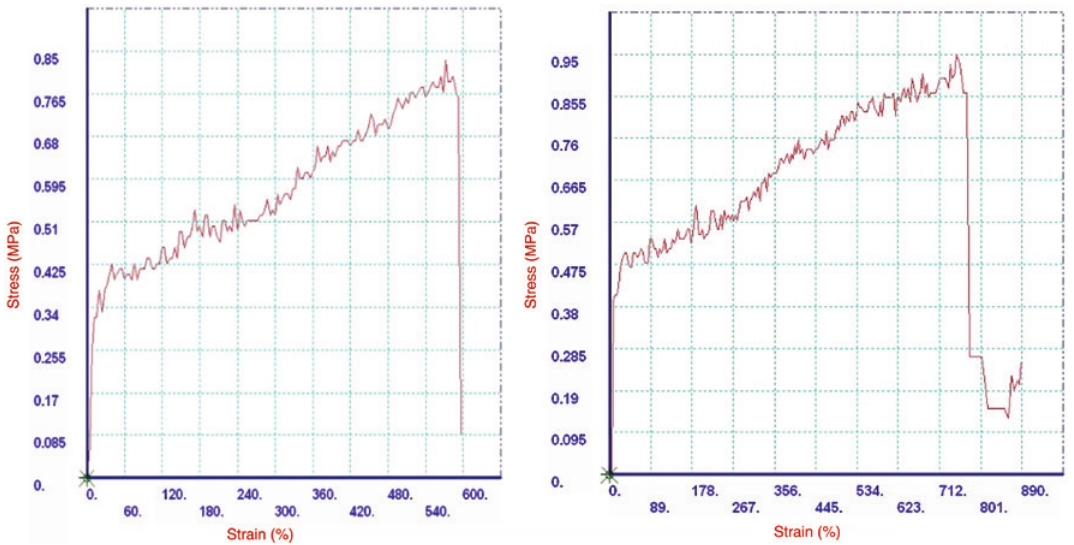
Figure 7: Stress-strain curve of coir fiber-reinforced vulcanized NR composite after cold resistance at − 60 ° C for 8 h.